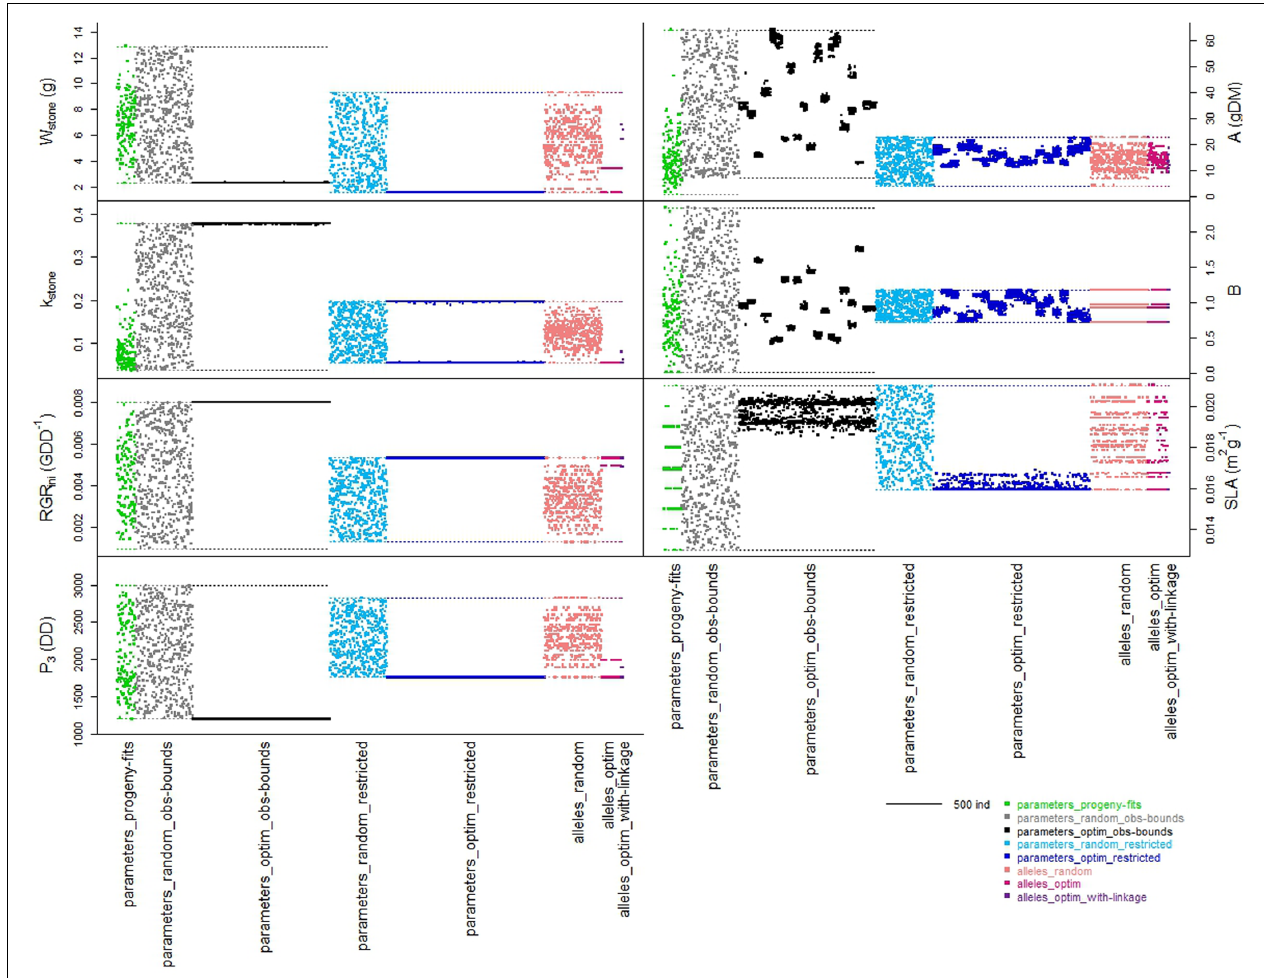
FIGURE 1 | Schematic representation of the distribution of the individuals from the different datasets within the spaces of the seven parameters of the process-based model. Colors represent the different datasets organized along the x -axes. Width of each dataset depends on the number of individuals in the dataset. Colored dotted lines represent the boundaries (minimal and maximal parameter values) of the spaces respectively to each